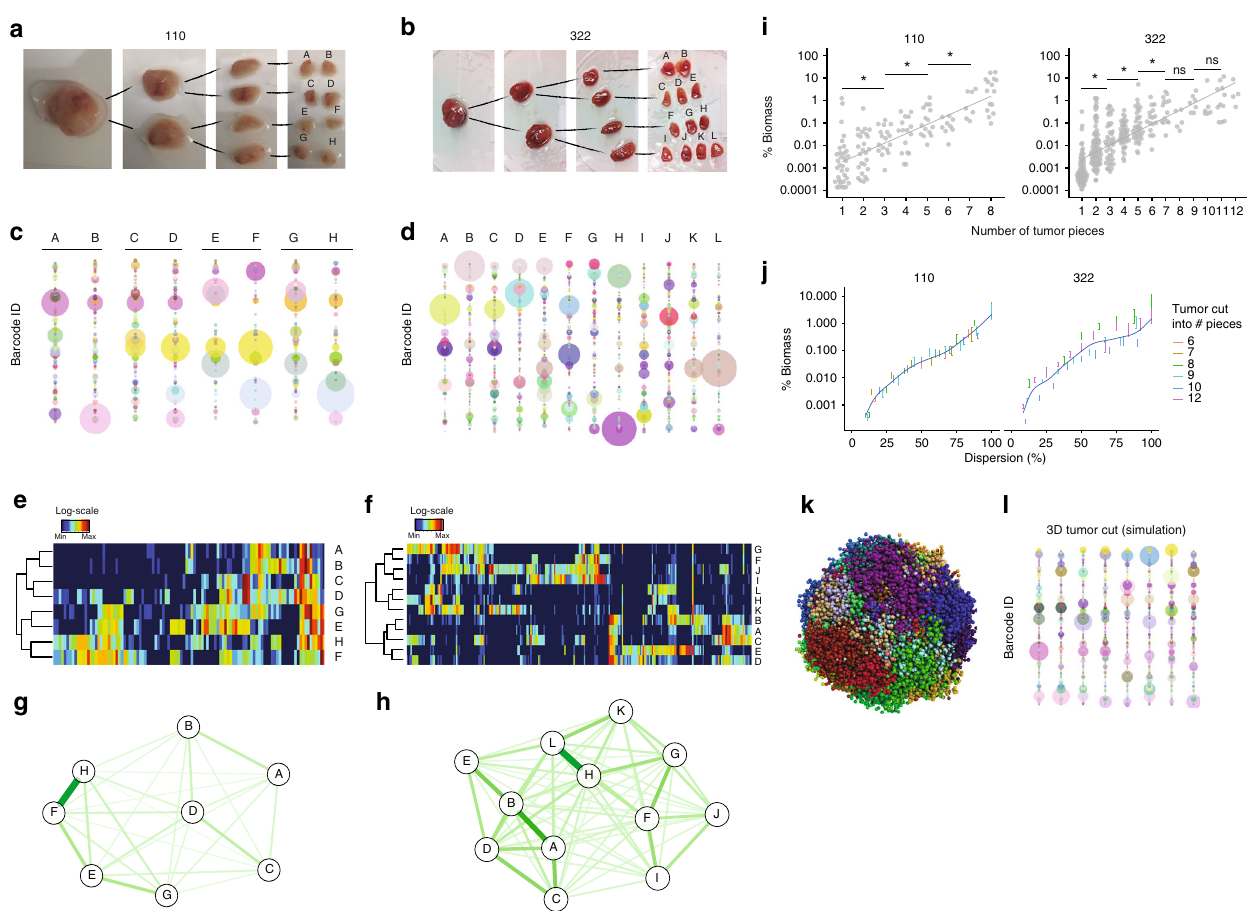
Fig. 2 Clonal mosaicism in three dimensions. Example of tumor cut into a Eight equal pieces for PDX-110 and b 12 equal pieces for PDX-322. c , d Representative bubble plot of clonal relationships between tumor pieces shown in a and b , respectively. Each barcode is represented by a dot of a given color, the size of the dot correlates with the number of reads after sequencing. The color codes are not related between different mice. e , f Heatmap representation with hierarchical clustering of clonal relationships for the example shown in a and b , with barcodes in columns and tumor pieces in rows. g , h Force-directed graph-based spatial reconstruction of tumor using Hellinger distance between barcode distributions in pieces. i Contribution to tumor biomass as a function of the number of pieces a given clone is detected for a and b . Welch two-sided two sample t -test, * p < 0.05, ns = non signi fi cant. j Relationship of % biomass and dispersion (de fi ned as the number of pieces a barcode is detected scaled by the total number of pieces per tumor) pooled over several mice (PDX-110: 17 mice, PDX-322, 19 mice). k Simulation and visualization of three-dimensional tumor growth, initiated with 200 barcoded PDX cells. Each dot is a cell, and colors indicate cells with different barcodes. l Bubble plot of a virtual tumor cut into eight equal